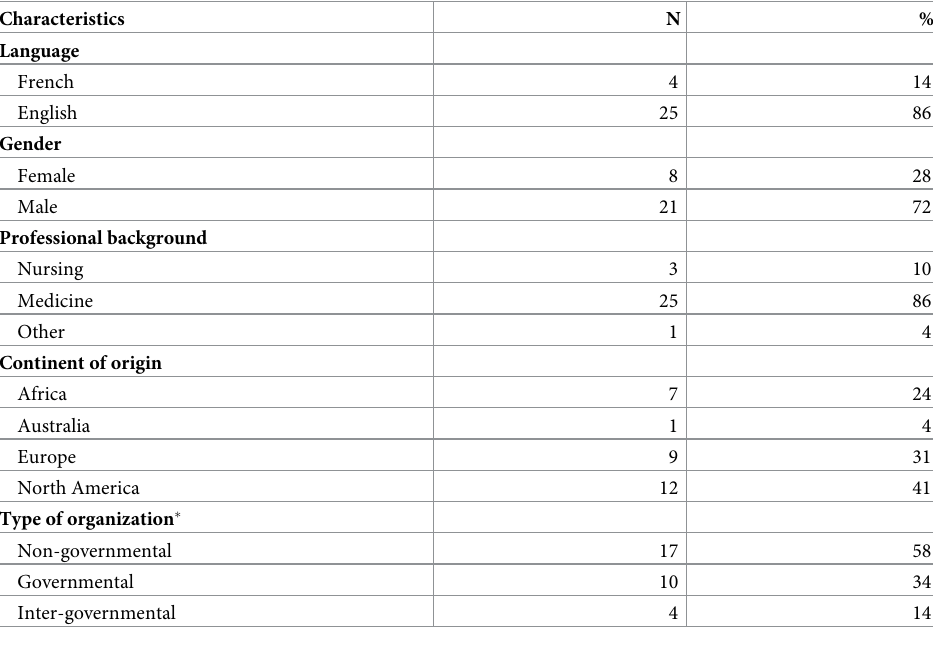
Table 1. Description of participants (n =